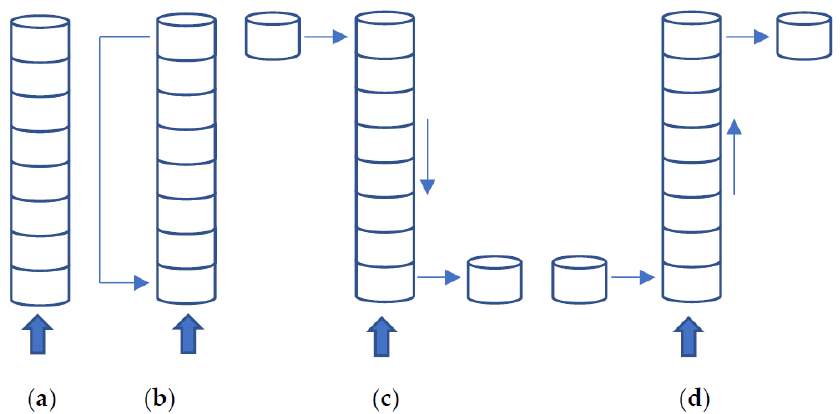
Figure 4. Different modes of operation that are possible with a modular multi-layered packed-bed bioreactor. ( a ) Batch operation; ( b ) Cyclic operation; ( c ) “Descending” semi-continuous operation; ( d ) “Ascending” semi-continuous operation. In all cases, the aeration is bottom-to-top, as indicated by the broad arrow. The thin arrows indicate the movement of modules. The diagrams represent the general principle of operation; details of how many modules were moved and with what frequency are given in the text and in Table 6.